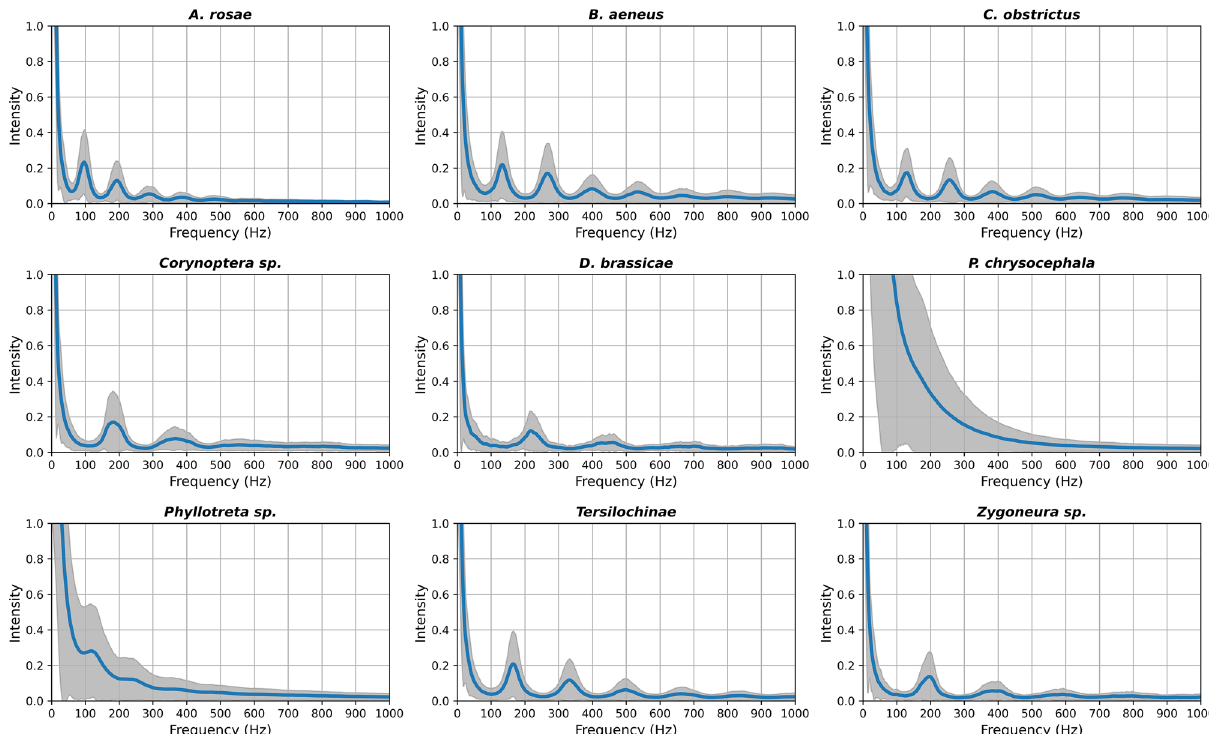
Figure 4. Average spectra of the wing beat frequency signals for the tested insects, showing the harmonics for each classified group. 1H first harmonic, 2H second harmonic, etc., exemplified for B. aeneus . The grey areas show the interquartile range. The spectra were obtained by taking the average over all four channels (808 nm and 1320 nm, co- and de-polarized